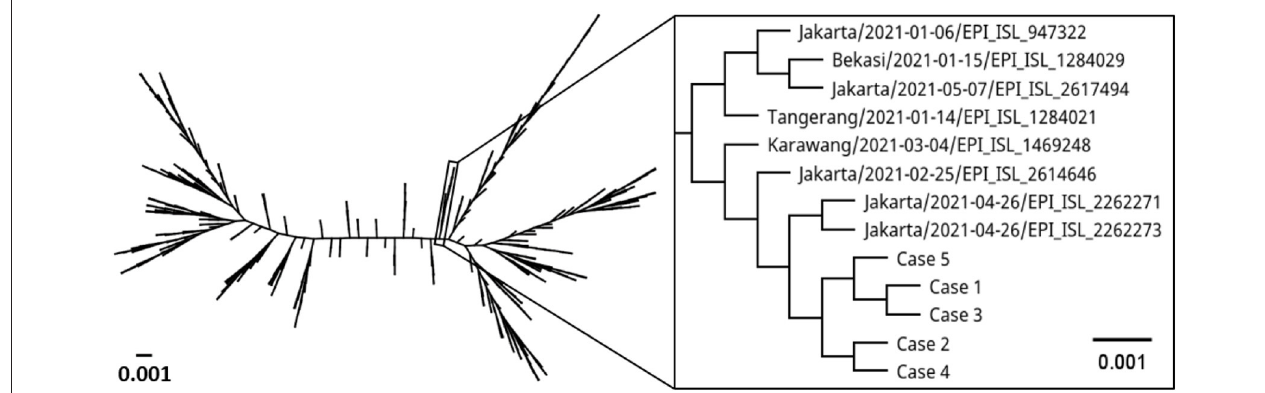
FIGURE 1 | Phylogenetic tree comparing whole genome of SARS-CoV-2 from the five pediatric cases with SARS-CoV-2 lineage B.1.470 from around the world and reference genome (Wuhan Hu1). Label indicates collection site/collection date/GISAID accession number. The scale bar represents the number of nucleotide substitution per